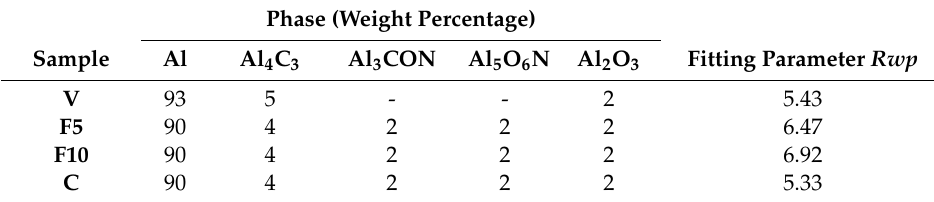
Table 4. Weight percentage of the phases after applied a heat treatment (400 ◦ C, 100